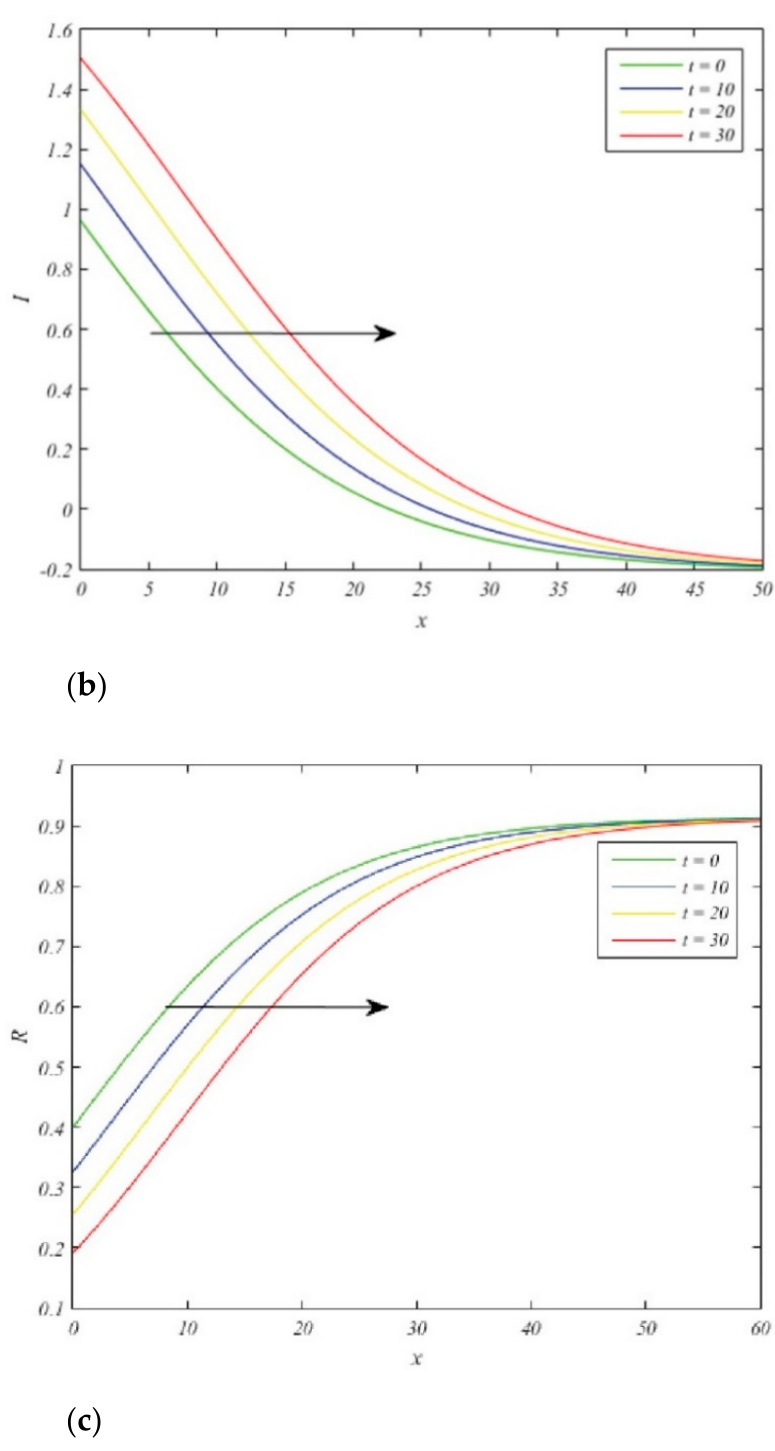
Figure 2. Traveling wave solution: ( a ) susceptible population per unit area; ( b ) infected population per unit area; ( c ) recovered population per unit area. The waves are plotted as functions of x for t between 0 (left most) and 30 (right most). Here, S ( 0,0 ) = 1.1345, I ( 0,0 ) = 0.9625, G ( 0,0 ) = 0.8, R ( 0,0 ) = 0.4, and other parameter values are as given in the text. The plots of wave fronts shown in Figure 2 contribute to our understanding of the manner in which the infection spreads through space and time. They depict the situation in which the infection starts out not being that widespread at the central point of the region of interest where x = 0, while some pigs remain healthy here. As time progresses,